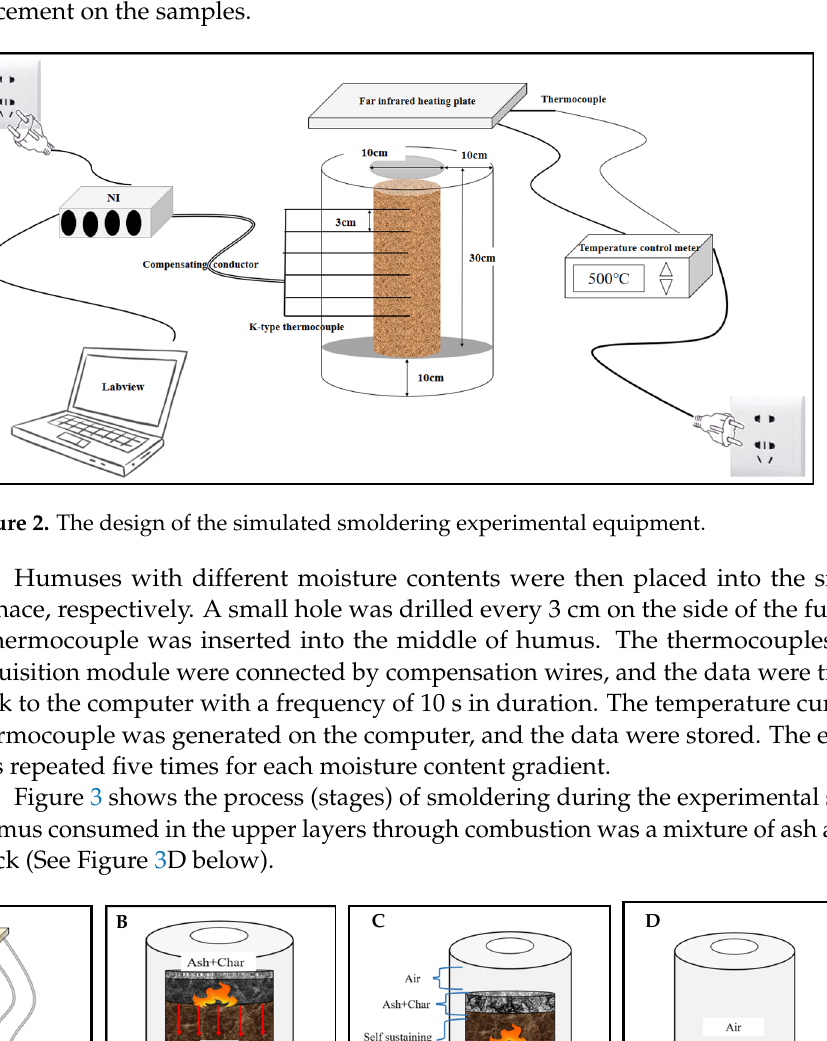
Figure 3. Process of the smoldering samples ( A : Igniting; B : Start self-sustaining combustion; C : Self-sustaining combustion; D : Completely extinguished).